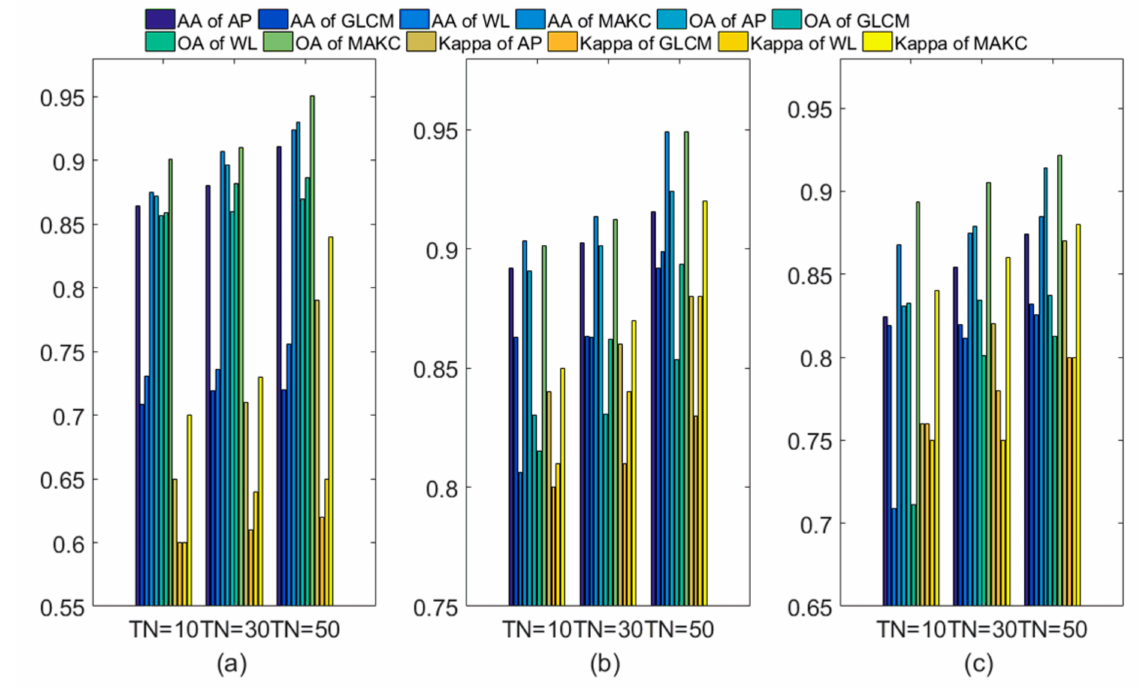
Figure 9. Classification result (in OA, AA, and Kappa) comparison among AP, GLCM, WL, and MAKC, with different numbers of training samples. This is demonstrated on ( a ) SAR1 image, ( b ) SAR2 image, and ( c ) SAR3 image. TN = n means the number of training samples is equal to n.